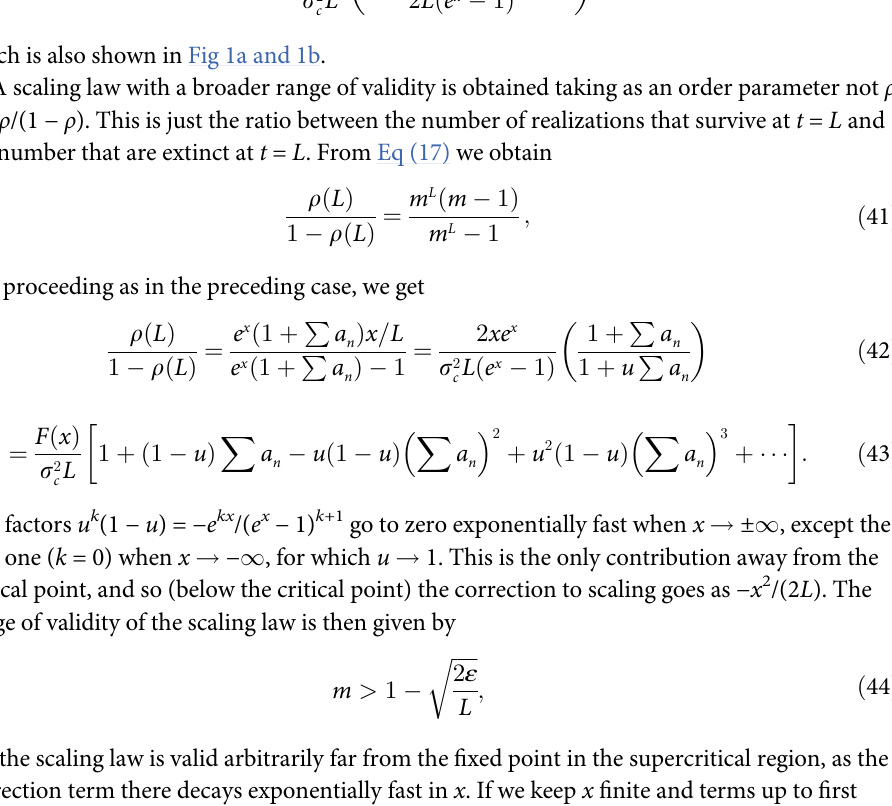
Fig 1. (a) Comparison of the exact probability of survival, ρ ( L ), given by Eq (17), with the approximations given by the scaling law Eq (22) and by the scaling law with the first correction to scaling, Eq (40), for different m and L . (b) The same taking the y – axis logarithmic. (c) The same data, taking the ratio between the approximation given by the scaling law [ F ð x Þ = ð s 2 c L Þ ], Eq (22), and the exact value of ρ ( L ). Larger values of L are included in this case. The program used to draw the fi gure is provided as S1